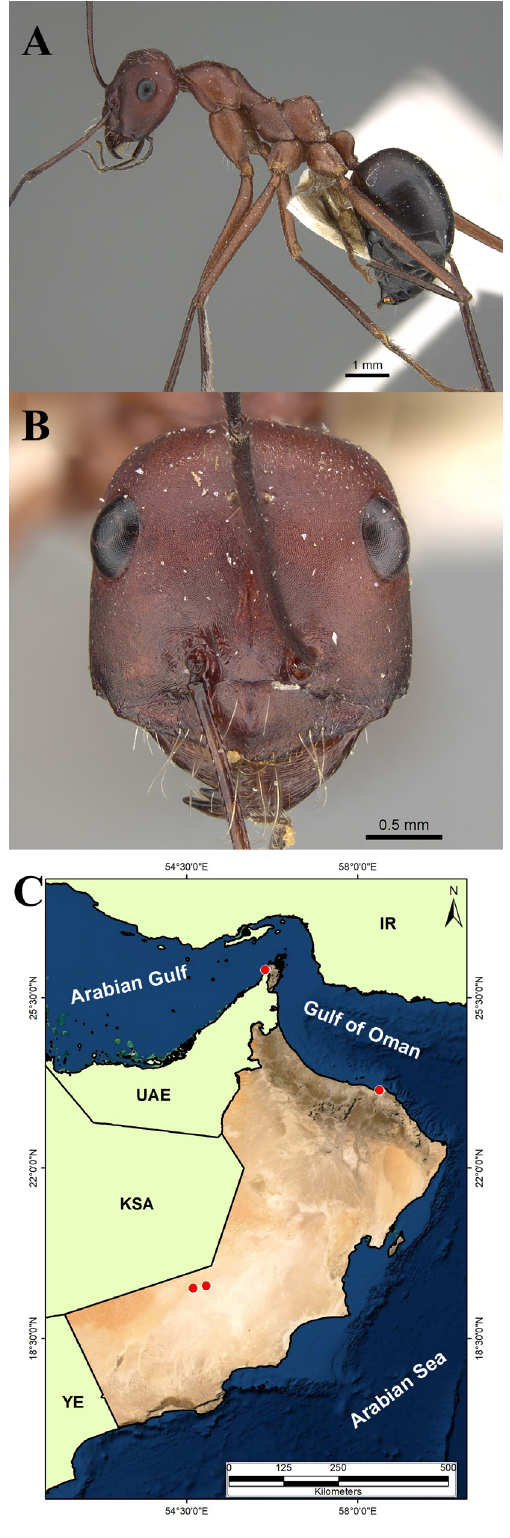
Fig. 14. Cataglyphis urens Collingwood, 1985, syntype, worker (CASENT0922340, AntWeb.org (Michele Esposito)). A . Body in profile. B . Head in full-face view. C . Distribution